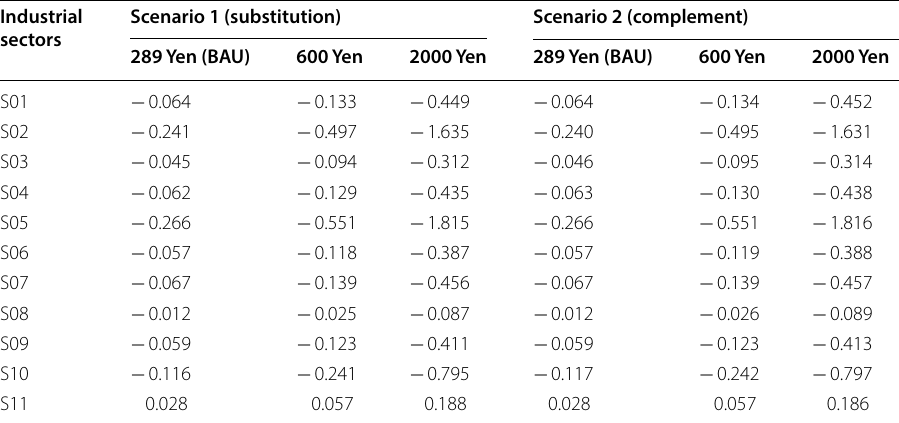
S01–S11 are the identifying numbers indicating industrial sectors shown in Table 1